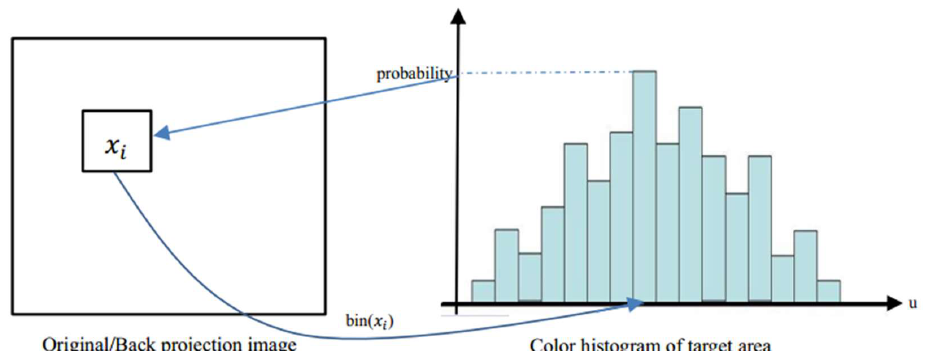
Figure 3. The process of obtaining the back-projection image.